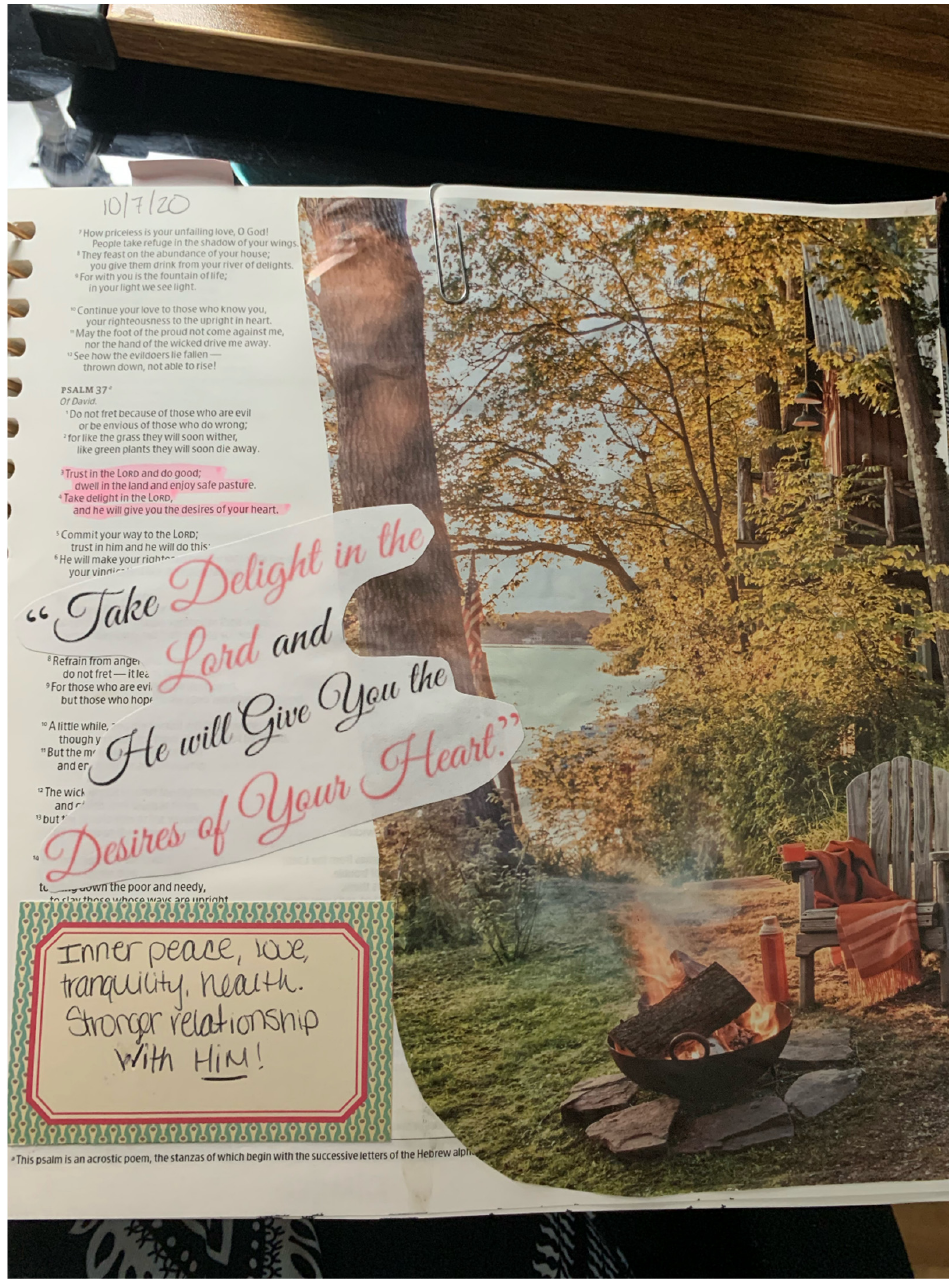
Figure 5. Psalm 37:3–4. With kind permission of the journaler.